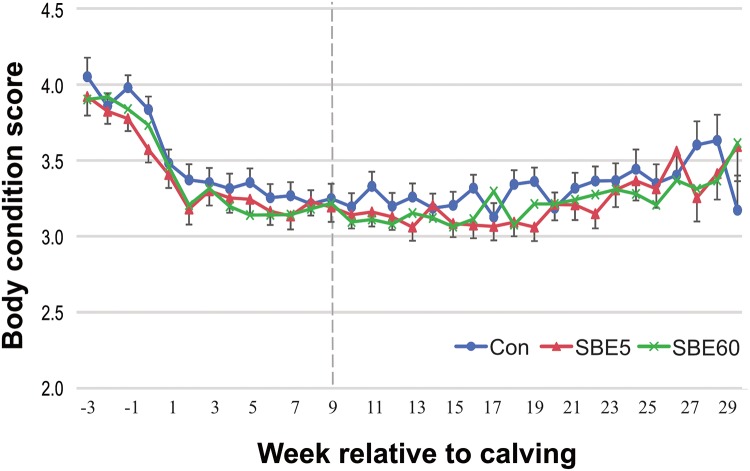
Body condition score (5 point scale) from 3 weeks prepartum to 29 weeks postpartum for control cows and cows supplemented with S. baicalensis extract (SBE) for the first 5 d (SBE5) or 60 d (SBE60) of lactation.Least square means across time were 3.40, 3.30, and 3.31 ± 0.06 for CON, SBE5, and SBE60, respectively. BCS differed by week (P < 0.001), but there were no differences by treatment (P = 0.44) or treatment × week (P = 0.57). Values are LS means ± pooled SEM, n = 39–42.